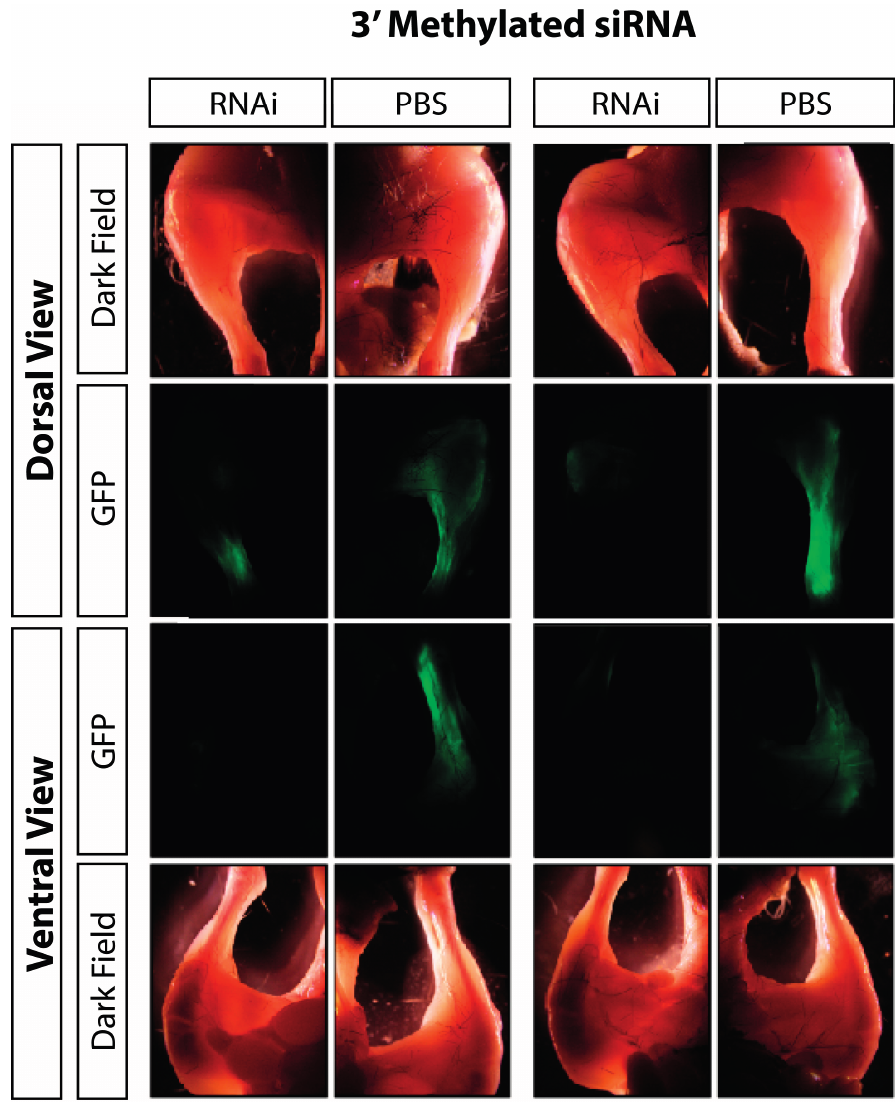
Figure 4. Efficacy of RNAi treatments with 3’ methylated Gfp siRNA. Nanogel NSPs were complexed at 1:1 ratios with two μ g of 3’ methylated (n = 5) siRNA (sequence 1). Treatments were injected to left hind limbs along with 2.2 × 10 8 PFU/site of Adex-GFP. Right hindlegs received the same amount of Adex-GFP mixed with the same volume of PBS. Levels of GFP were observed from dorsal and ventral sides. Mean GFP expression in RNAi-treated limbs was 2.75 ± 1.24% and mean expression in control (PBS-treated) limbs was 5.99 ± 1.41% ( p =